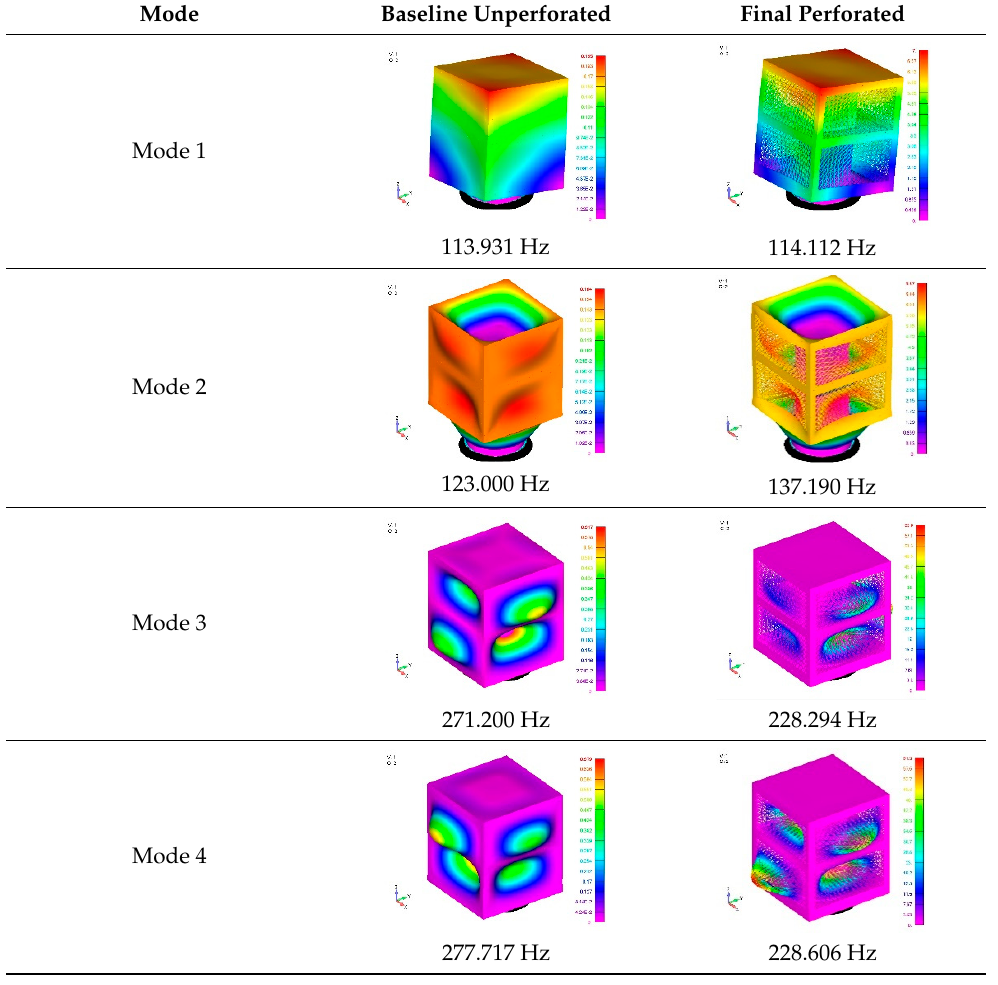
236.415 Hz Table 8. Comparison between the effective modal mass fractions of the baseline unperforated and final perforated designs. (a) Baseline Unperforated Design Mode